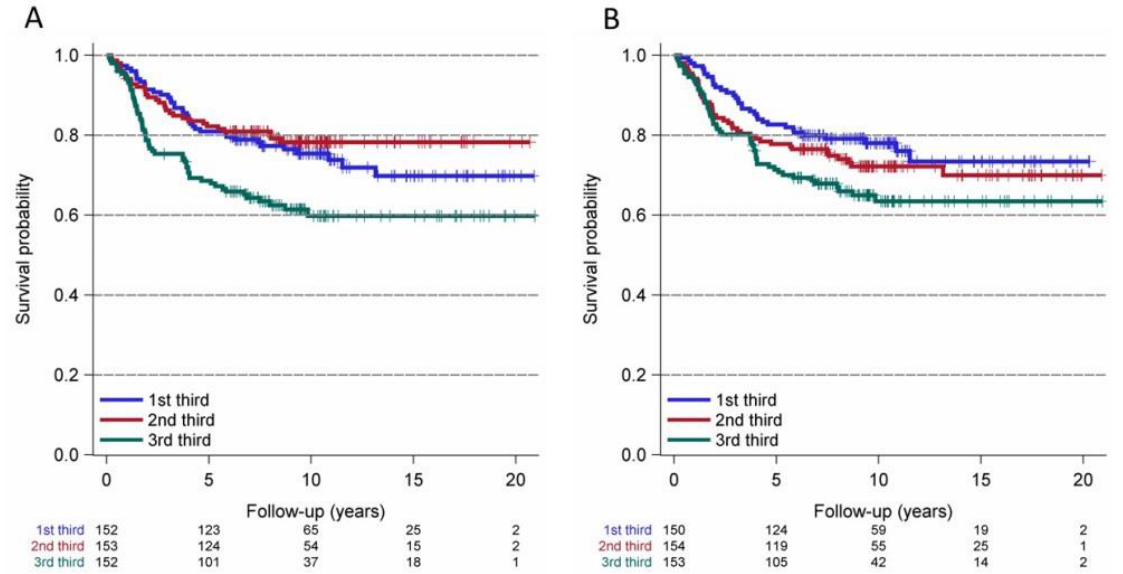
Figure 3. Kaplan–Meier curves for relapse-free survival of cutaneous melanoma patients and thirds of the pan-immune inflammation value (PIV, ( A ): 1st third-PIV ≤ 219.73; 2nd third-PIV > 219.73 to 393.73; 3rd third-PIV > 393.73) and the neutrophil-to-lymphocyte ratio (NLR, B ): 1st third-NLR ≤ 2.02; 2nd third-NLR > 2.02 to 3; 3rd third-NLR > 3). 3rd thirds of PIV ( A ) and NLR ( B ) appear to be associated with poorer relapse-free survival (hazard ratio: 1.718, 95% CI 1.143 to 2.584 and hazard ratio: 1.702, 95% CI 1.104 to 2.623, respectively).